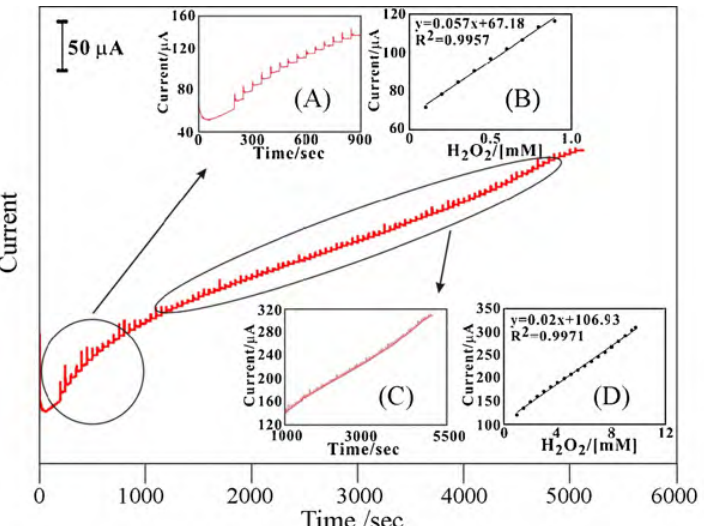
Figure 11. Amperometric responses of sequential additions of H 2 O 2 at the MWCNT–PEDOT/GCE in pH 7 PBS. Rotating speed = 2000 rpm, E app . = − 0.5 V. The blank amperometric response of MWCNT–PEDOT/GCE is tested during 0–200 s. Inset: ( A ) scale-up amperometric response to the first H 2 O 2 additions; ( B ) calibration plot of H 2 O 2 concentration; ( C ) amperometric response to H 2 O 2 ; ( D ) complete calibration plot. With permission from